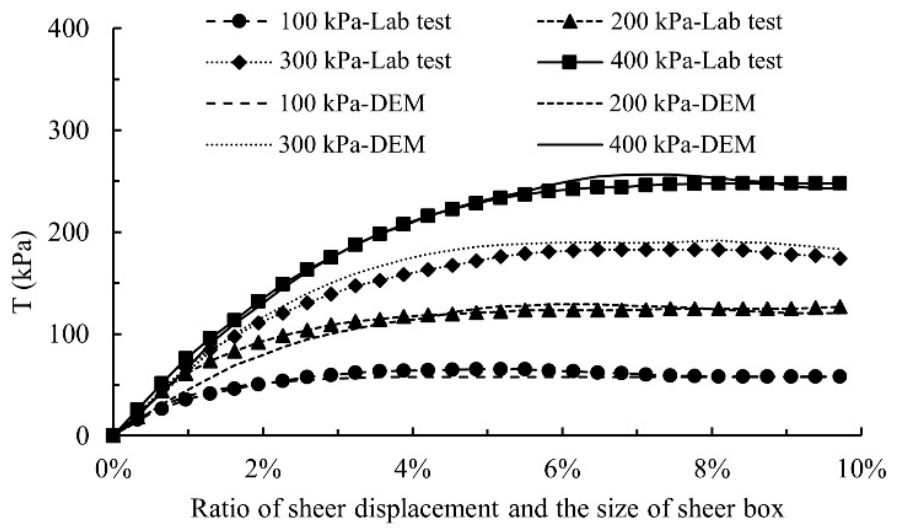
Figure 5. Curve fitting of shear force and shear displacement ratio of silty sand under 100–400 kPa pressure obtained from laboratory direct shear tests and DEM direct shear tests. Table 2. Micro-parameters of silty sand in the DEM model.